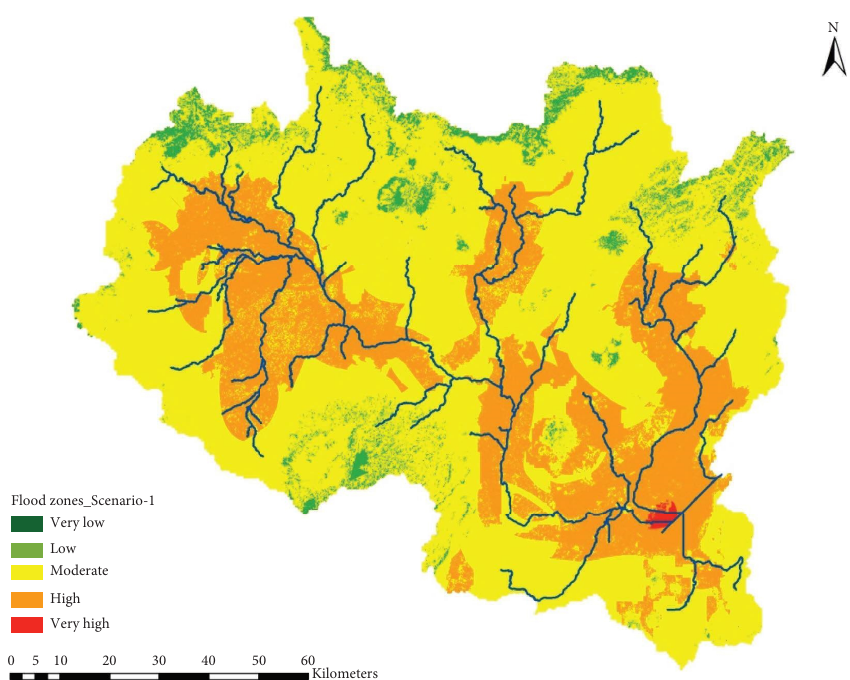
Figure 5: Flood hazard zone for the of base-case scenario (Scenario-1).